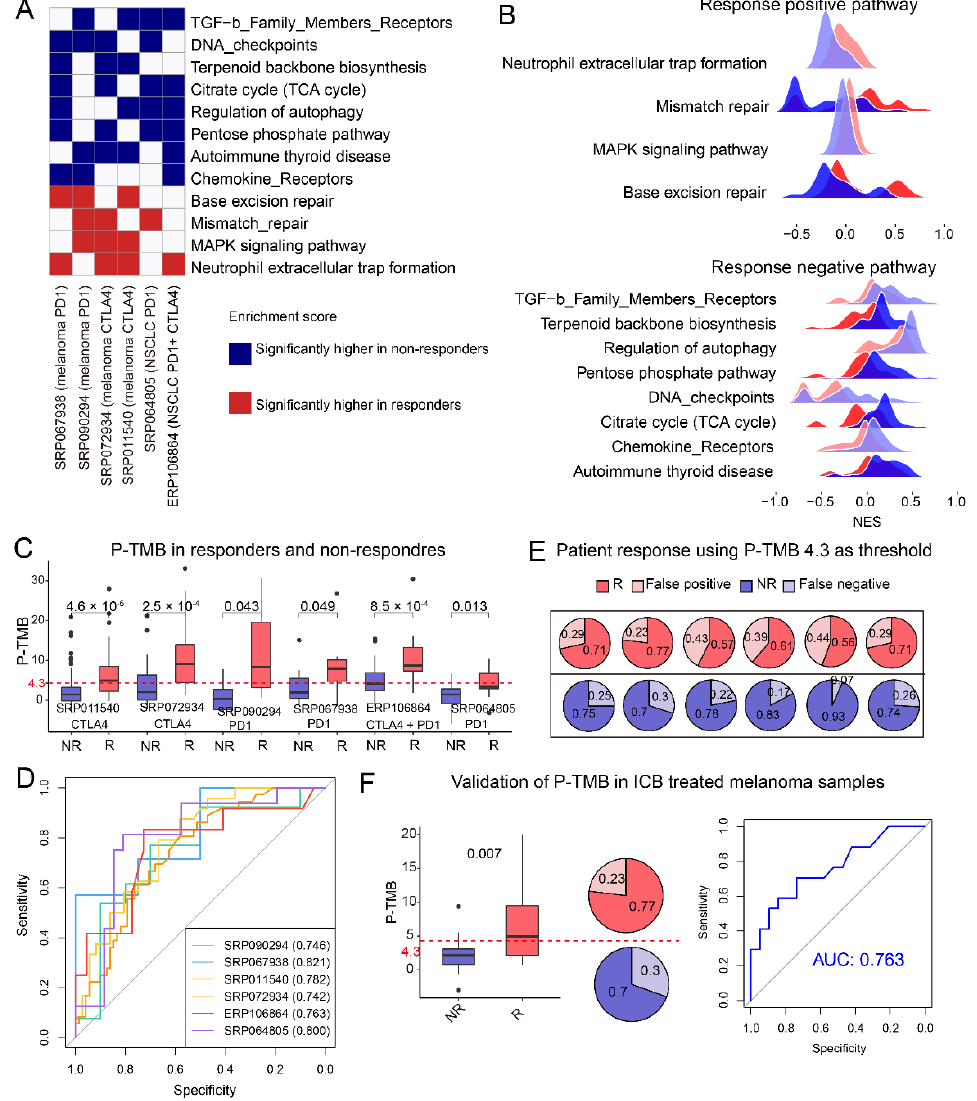
Figure 4. Biological pathways associated with response and pathway-derived TMB. ( A ). Heat map showing biological pathways with a normalized enrichment score (NES) significantly different between responders and non-responders. ( B ). Ridge plots present the NES of mutated genes in response positive pathways and negative pathways in samples from six datasets. NES of mutated genes in non-responders and responders were presented in blue color and red color, respectively. ( C ). Boxplot of distributions of P-TMB in responders and non-responders in all six datasets. ( D ). Receiver operating characteristic (ROC) curves for prediction of patient response using P-TMB as a feature. ( E ). The proportion of responders and non-responders in group with P-TMB > 4.3 (red color) and the opposite (blue color). ( F ). Validation of P-TMB in newly collected ICB-treated melanoma samples (GSE91061).